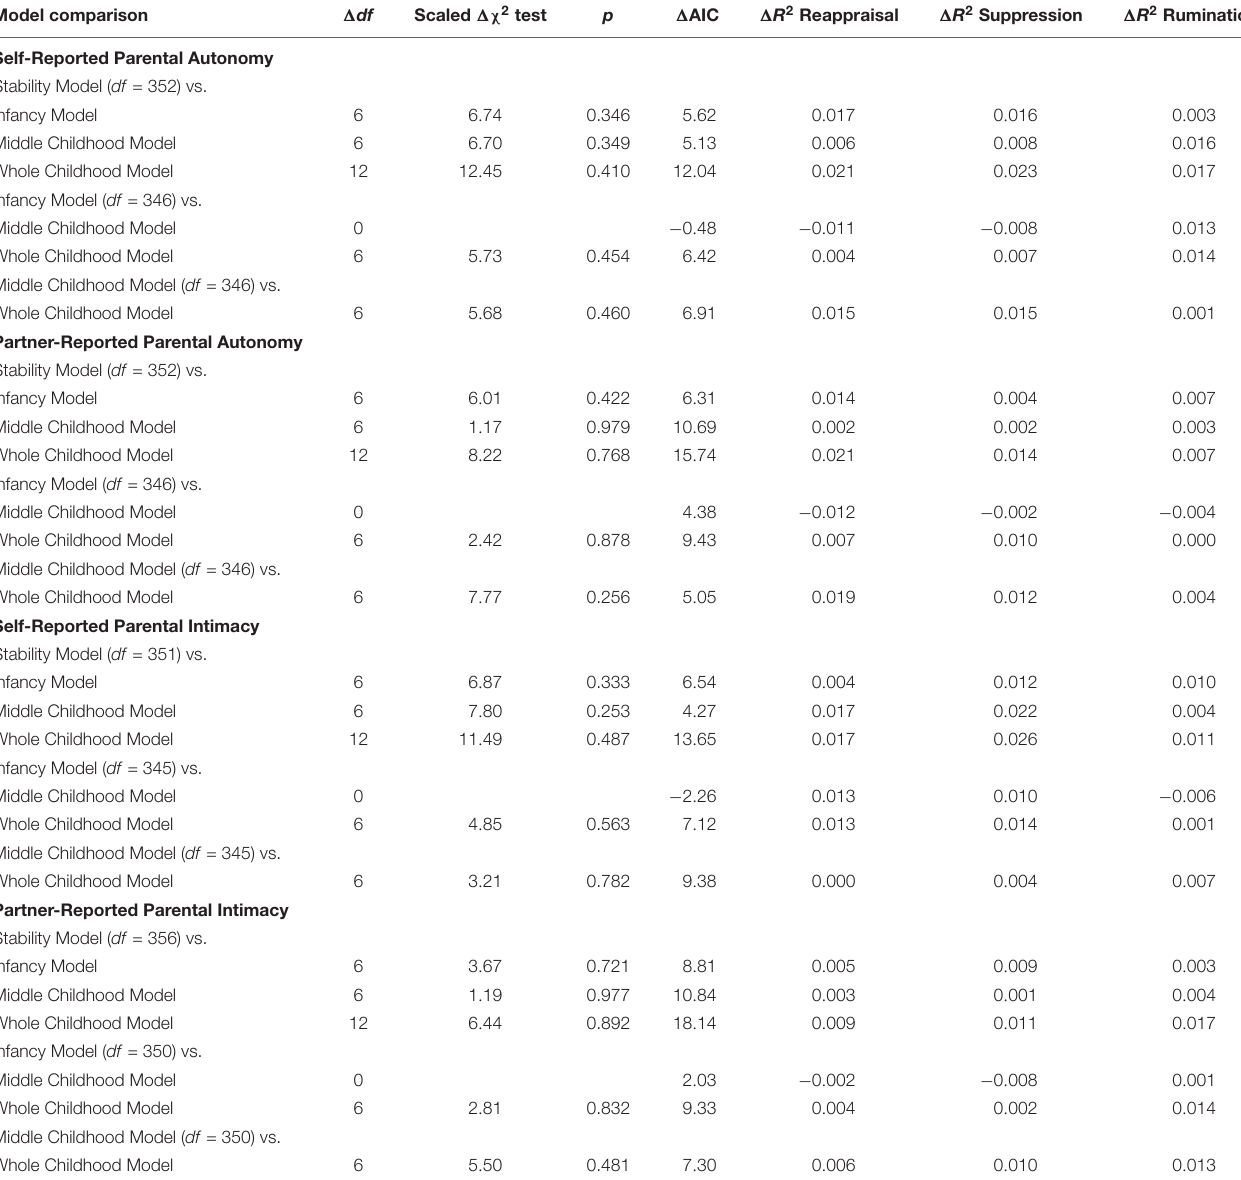
TABLE 1 | Comparisons of developmental timing models. Model